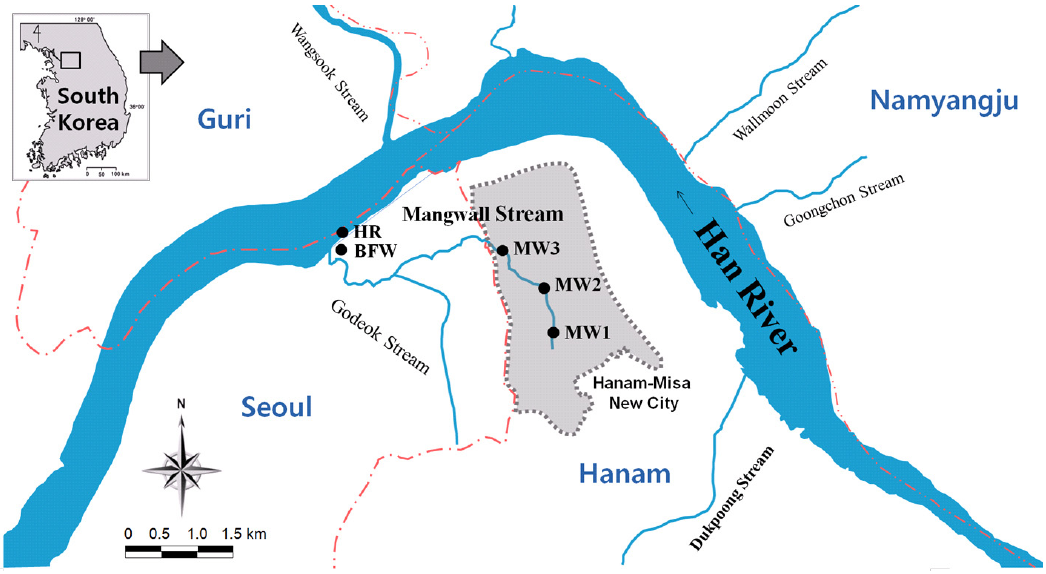
Figure 1. Site description and sampling points investigated in this study (gray area: Hanam-Misa New City, located in Hanam-si, South Korea; MW: Mangwall Stream; HR: Han River; BFW: bank filtration